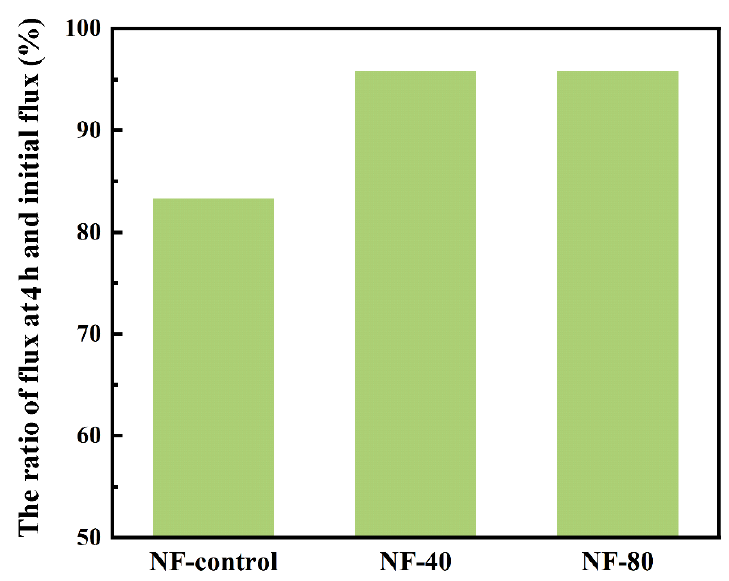
Figure 10. The ratio of flux at 4 h and initial flux, containing NF-control, NF-40, and NF-80 membranes after 4 h fouling test using 200 mg/L sodium alginate.